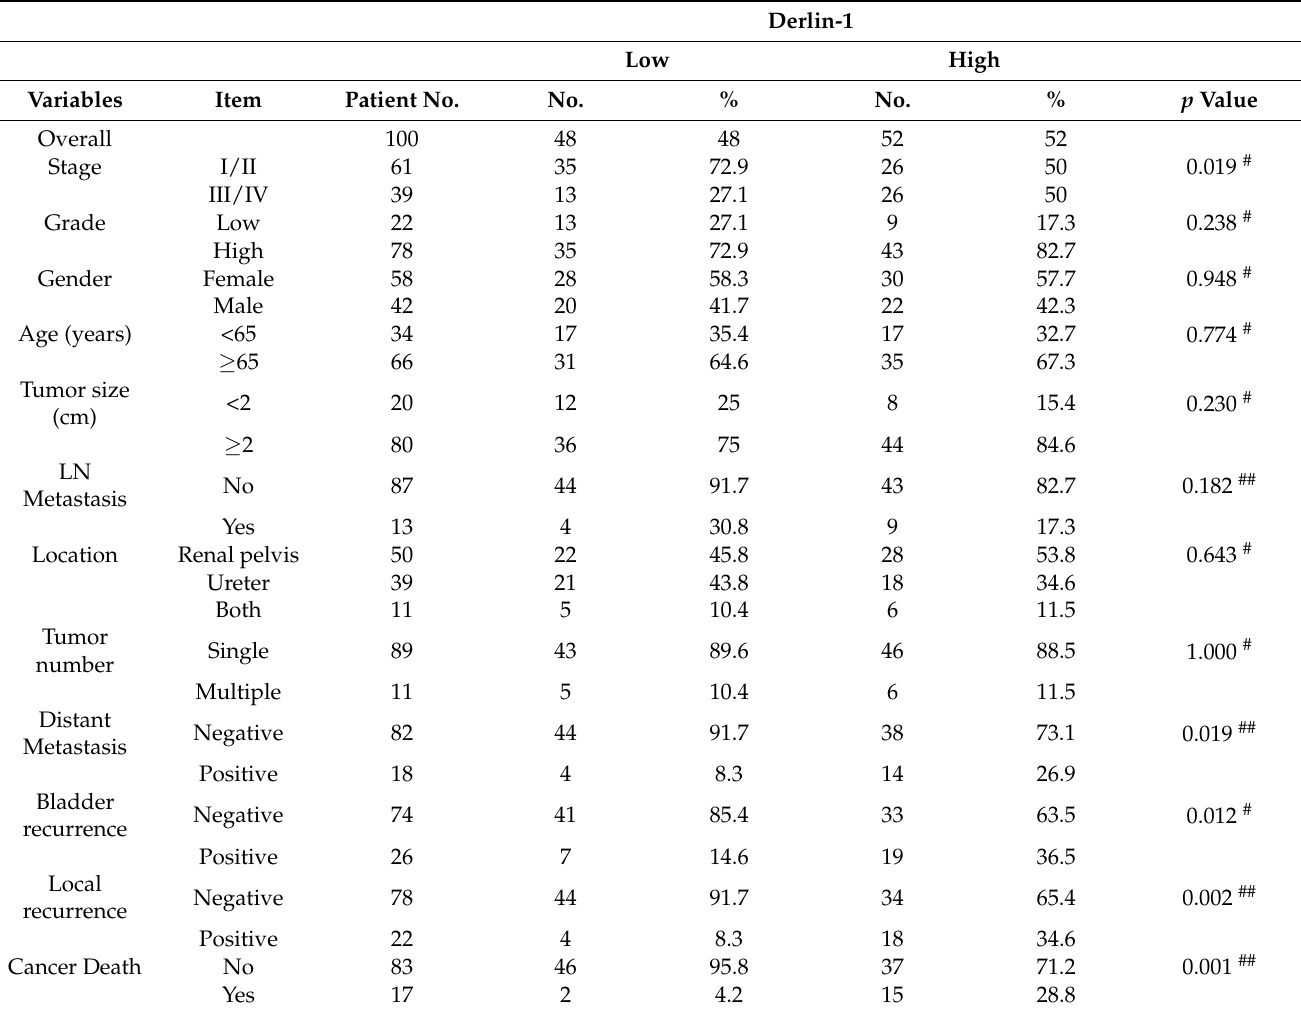
Table 1. Association of Derlin-1 with clinicopathological characteristics in UTUC.